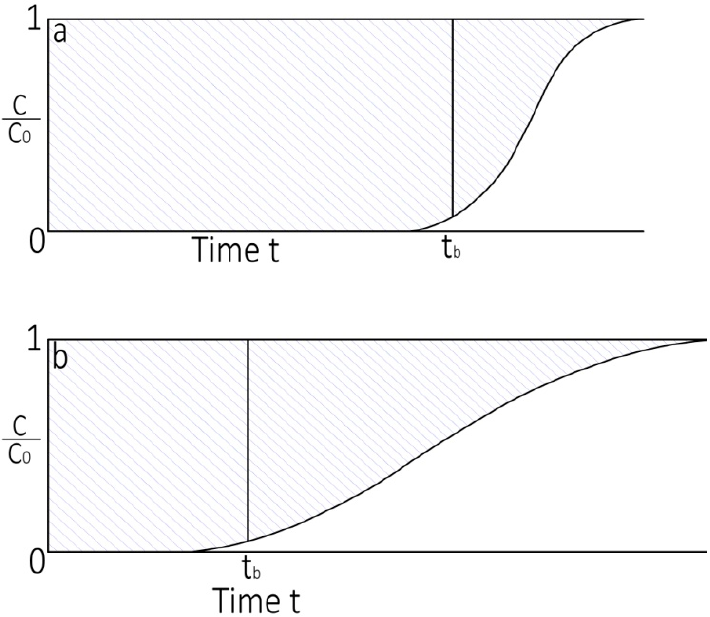
Figure 14. ( a ) Breakthrough profile and narrow MTZ and ( b ) breakthrough profile and wide MTZ.